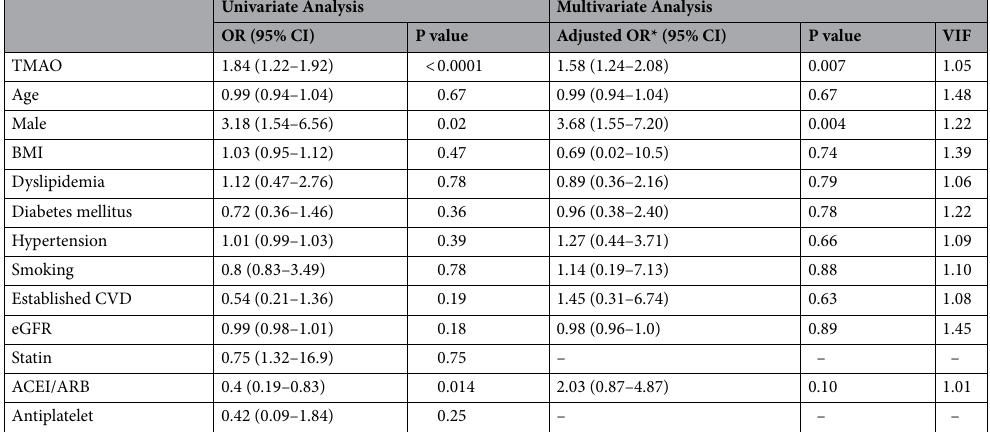
Table 2. Univariate and Multivariate Logistic Regression for Prediction of Subclinical Myocardial Damage (hs-cTnT ≥ 14 ng/L). *Adjusted for age, male, BMI, dyslipidemia, diabetes mellitus, hypertension, smoking,